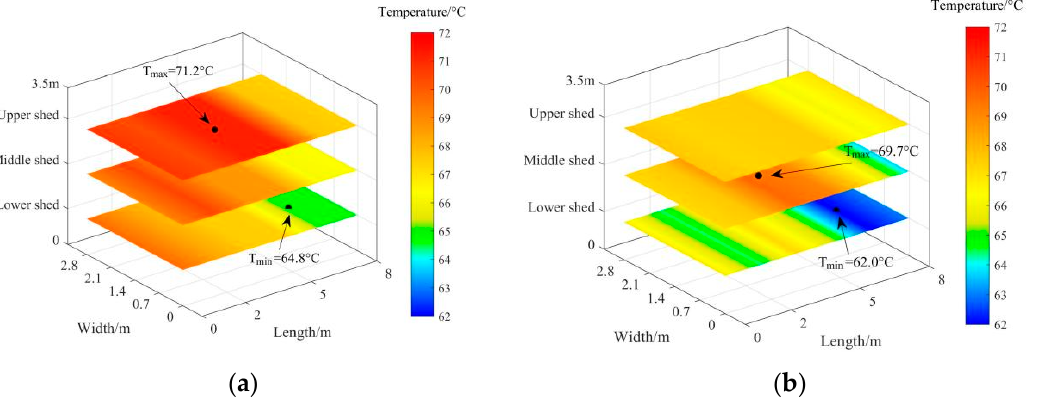
Figure 8. The temperature distribution of ( a ) TCCB and ( b ) HPCB with a curing temperature of 68